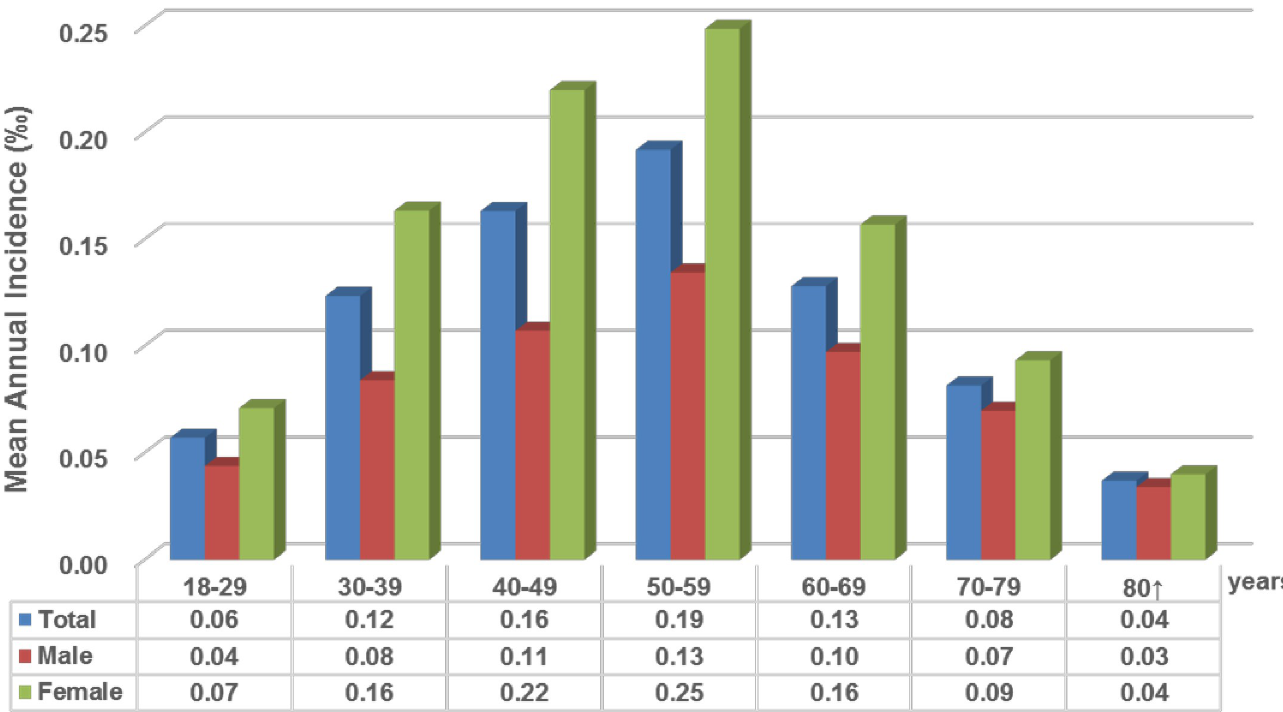
Fig 2. Age- and sex-specific incidence of benign essential blepharospasm,